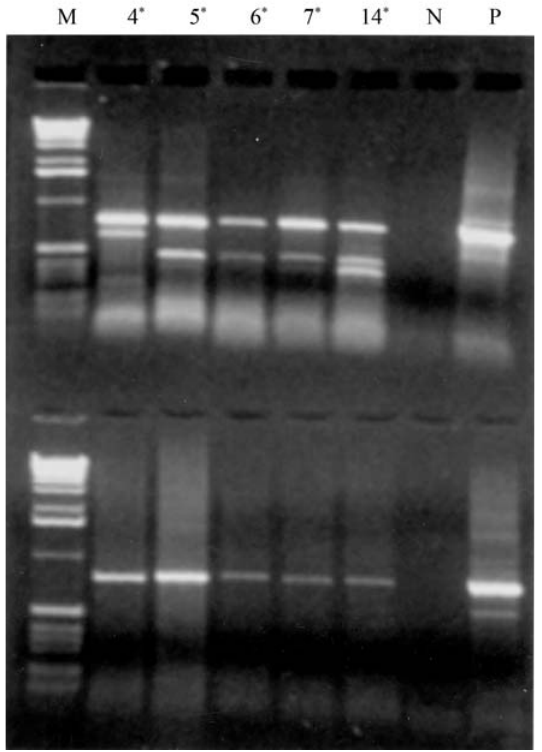
Figure 2 - PCR products of the DNA extracts numbers 4*, 5*, 6*, 7*, and 14*,respectively.NandPstandfornegativeandpositivecontrols,respec- tively. No BSA was added in the reactions, primer concentrations of 0.4 (cid:2) M and 0.2 (cid:2) M were used for upper bands and lower bands, respec- tively. “M” identifies the 1 kb